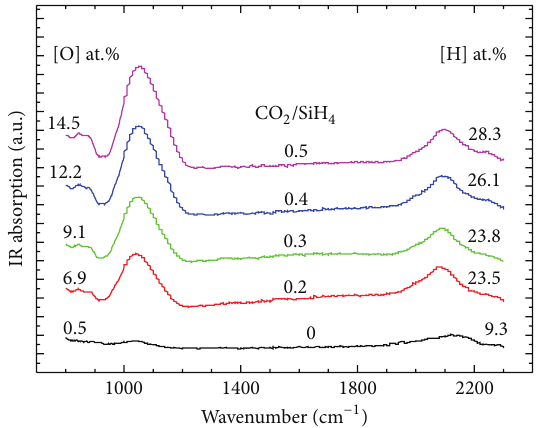
Figure 3: Infrared absorption spectra of p- 𝜇 c-Si 1−𝑥 O 𝑥 :H films as a function of CO 2 /SiH 4 ratio with oxygen and hydrogen concentra- tion.